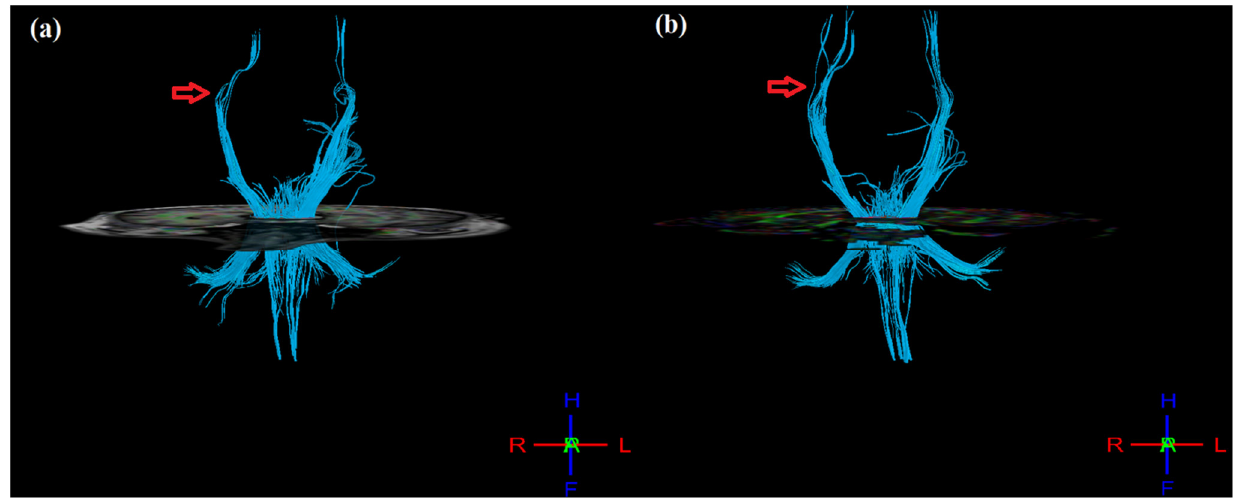
Figure 4. 3D tractography images of CST of both hemispheres ( a ) pre- and ( b ) post-therapy. Post- therapy image of affected (right) hemisphere indicating denser and more intact tracts as compared to pre-therapy (indicated by red arrow mark). Table 3. Mean FA and aFA values obtained from pre-and post-VR therapy DTI in masked regions of patient ‘P’. Right (Ipsilesional Hemisphere) Left (Contralesional Hemisphere) Region aFA aFA Mean FA Values Mean FA Values PRE